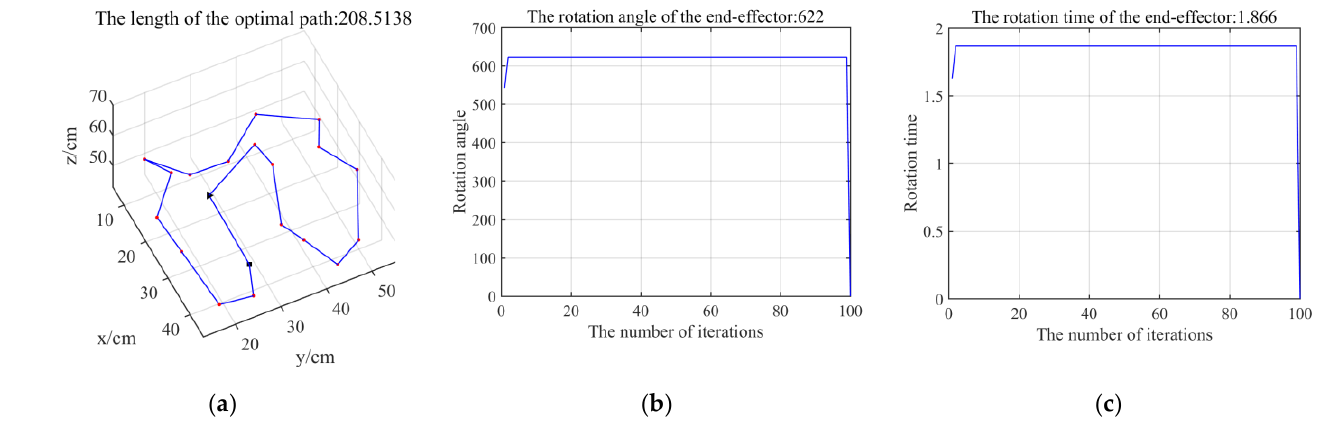
Figure 10. Simulation results of traditional ACA: ( a ) Path planning results; ( b ) Path length change curve; ( c ) Sum of waiting times of shortest paths.